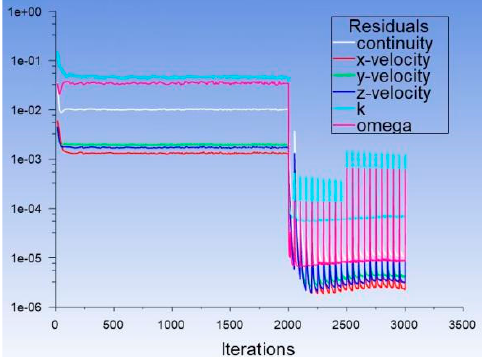
Figure 12. Residual change curve of steady-state calculations bridging to transient calculations (until t = 0.02 s).